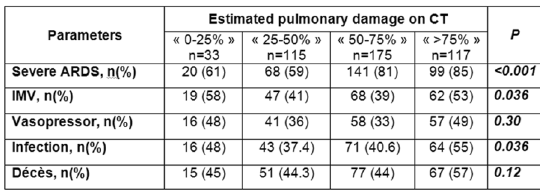
Table I. Conclusion: Initial quantitative assessment of COVID-19 lesions may predict severity and outcomes in patients admitted with SARS-COV2 pneumonia.